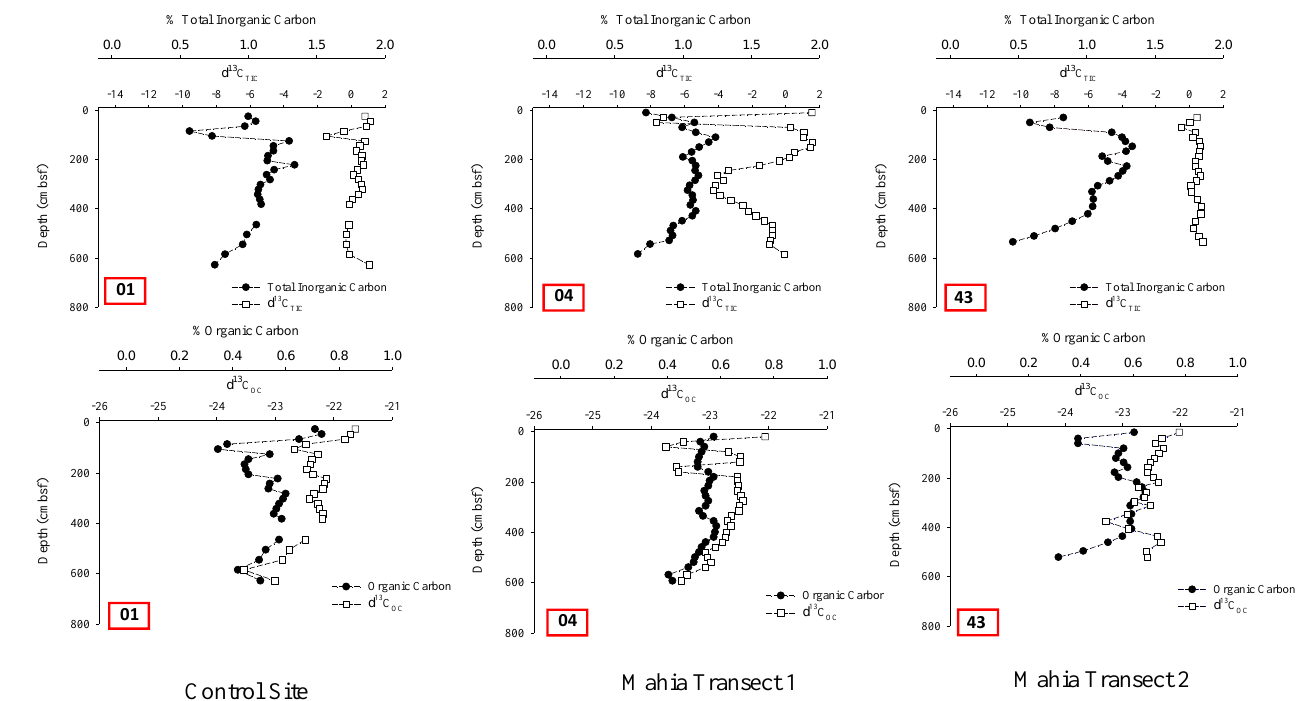
Figure 8. A comparison of sediment core total inorganic and organic carbon concentrations and d 13 C through piston core profiles. Sediment carbon profiles are presented from the core sites with highest vertical CH 4 flux. Piston core numbers presented in seismic and TOPAS profiles (Figures 2, 4 and 6) are indicated in red boxes.